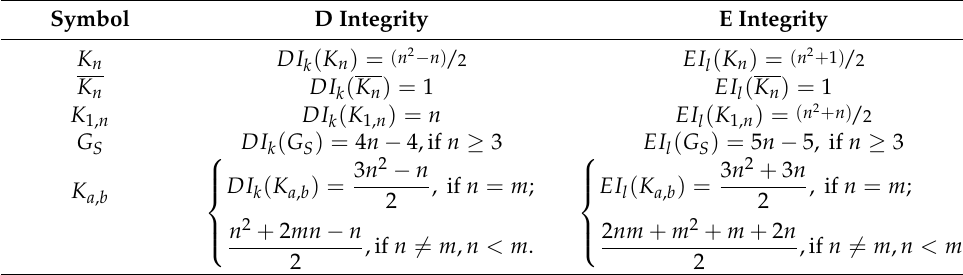
Table 2. D and E integrity of some well-known sorts of graphs. Symbol D